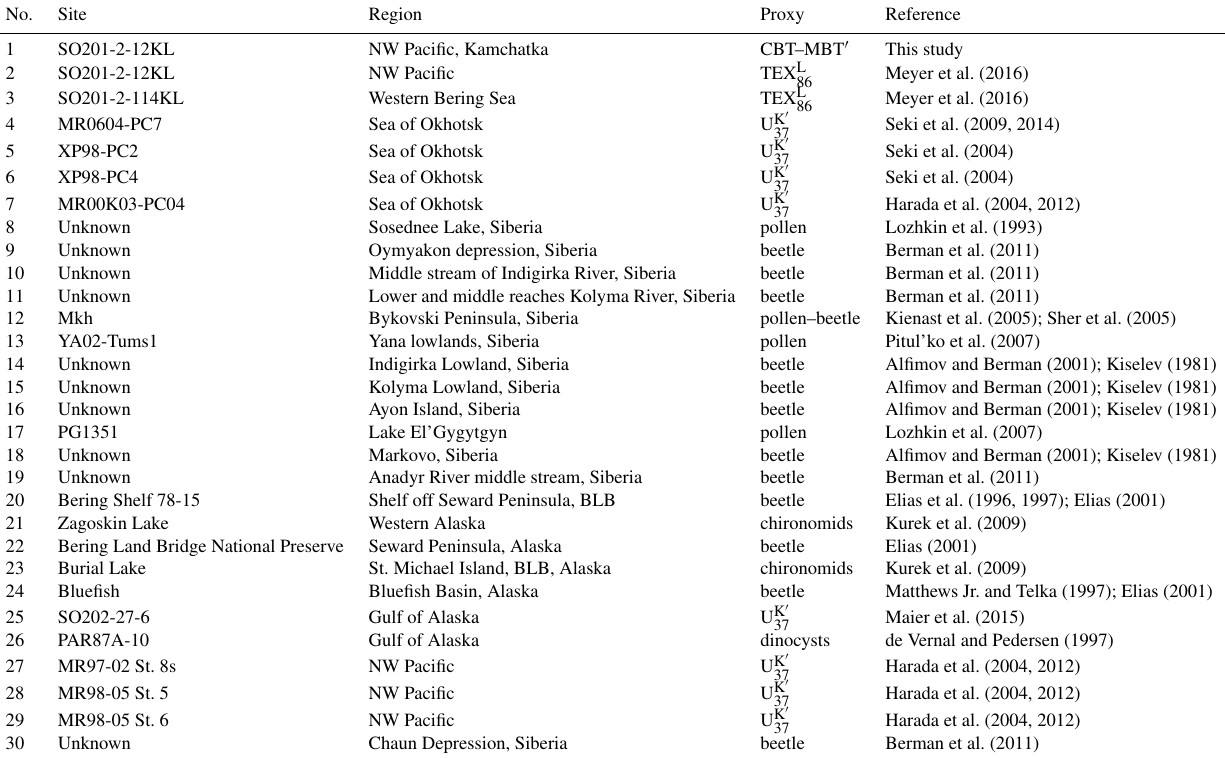
Table A1. Sites and references for the data compiled in Fig. 4c. BLB: Bering Land